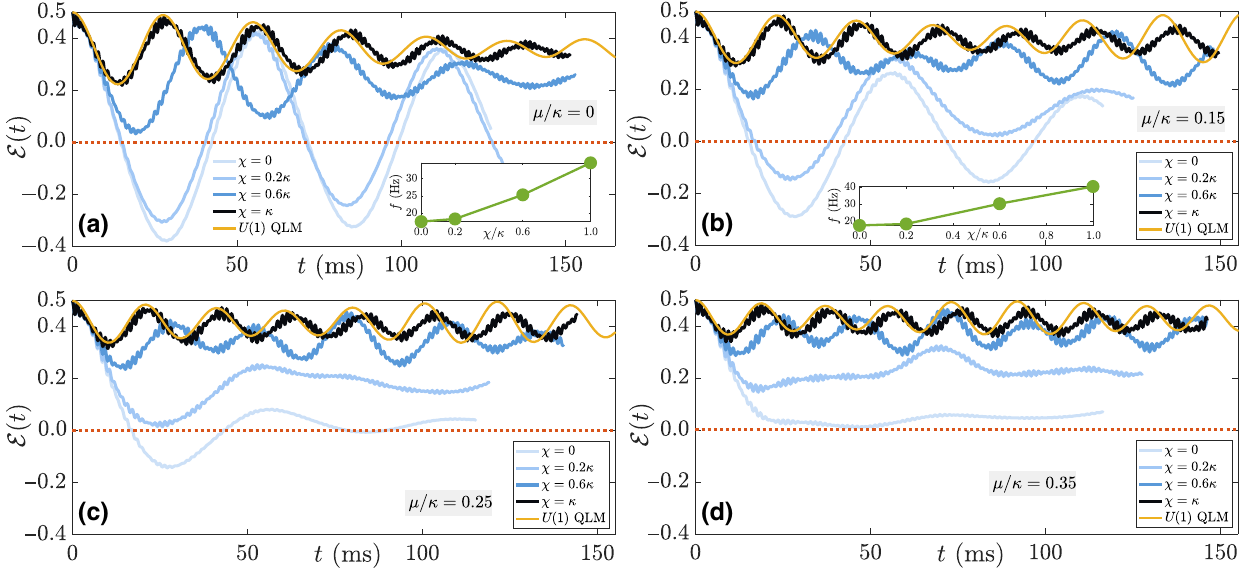
FIG. 5. t DMRG calculations of the dynamics of the electric flux for a quench of the vacuum state with Hamiltonian (5) at mass (a) μ/κ = 0, (b) μ/κ = 0.15, (c) μ/κ = 0.25, and (d) μ/κ = 0.35, with the topological term at strength χ/κ = 0, 0.2, 0.6, 1 (from light to dark blue). Solid yellow curve depicts the corresponding dynamics in the ideal U ( 1 ) QLM (3) for the same quench at χ/κ = 1, as obtained from ED. As χ increases, confinement forces the electric field to remain close to its initial value throughout all considered evolution times. For nonzero rest mass, the persistent oscillations are enhanced, exhibiting a larger frequency with increasing χ . It is worth noting here that the massless quench at χ = 0 exhibits quantum many-body scarring, first observed in a Rydberg-atom setup [42]. This type of scarring, which involves state transfer between the two degenerate vacua of QED, is undermined in the strongly confined regime, where the wave function remains close to the initial state at all evolution times (see text). For the small-mass quenches in (a),(b), we add insets showing the estimated frequency of oscillations as a function of χ , as a rough metric of